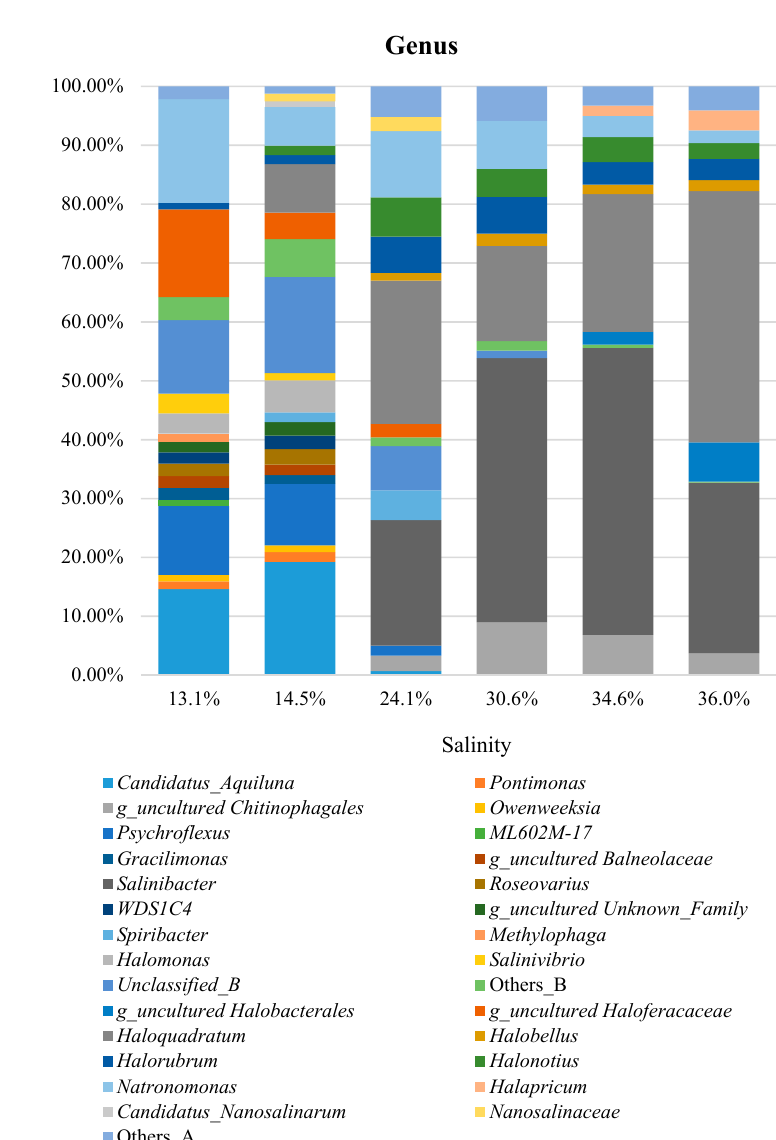
Figure 6. Bar charts of taxonomic classification of Bacteria and Archaea identified in MdS saltern. ( A ) phyla; ( B ) genera. Relative abundances (RA i ) were obtained applying the formula RA i = RA i,m *RA D,cf / 100, where RA i,m is the relative value obtained by metabarcoding analysis and RA D,cf is the relative abundance of the parental domain obtained by CARD-FISH analysis. Groups with relative abundances < 1.0% were joined as ‘Others_B’ and ‘Others_A for Bacteria and Archaea , respectively. A list of all the identified genera and their relative abundances is reported in Table S6.